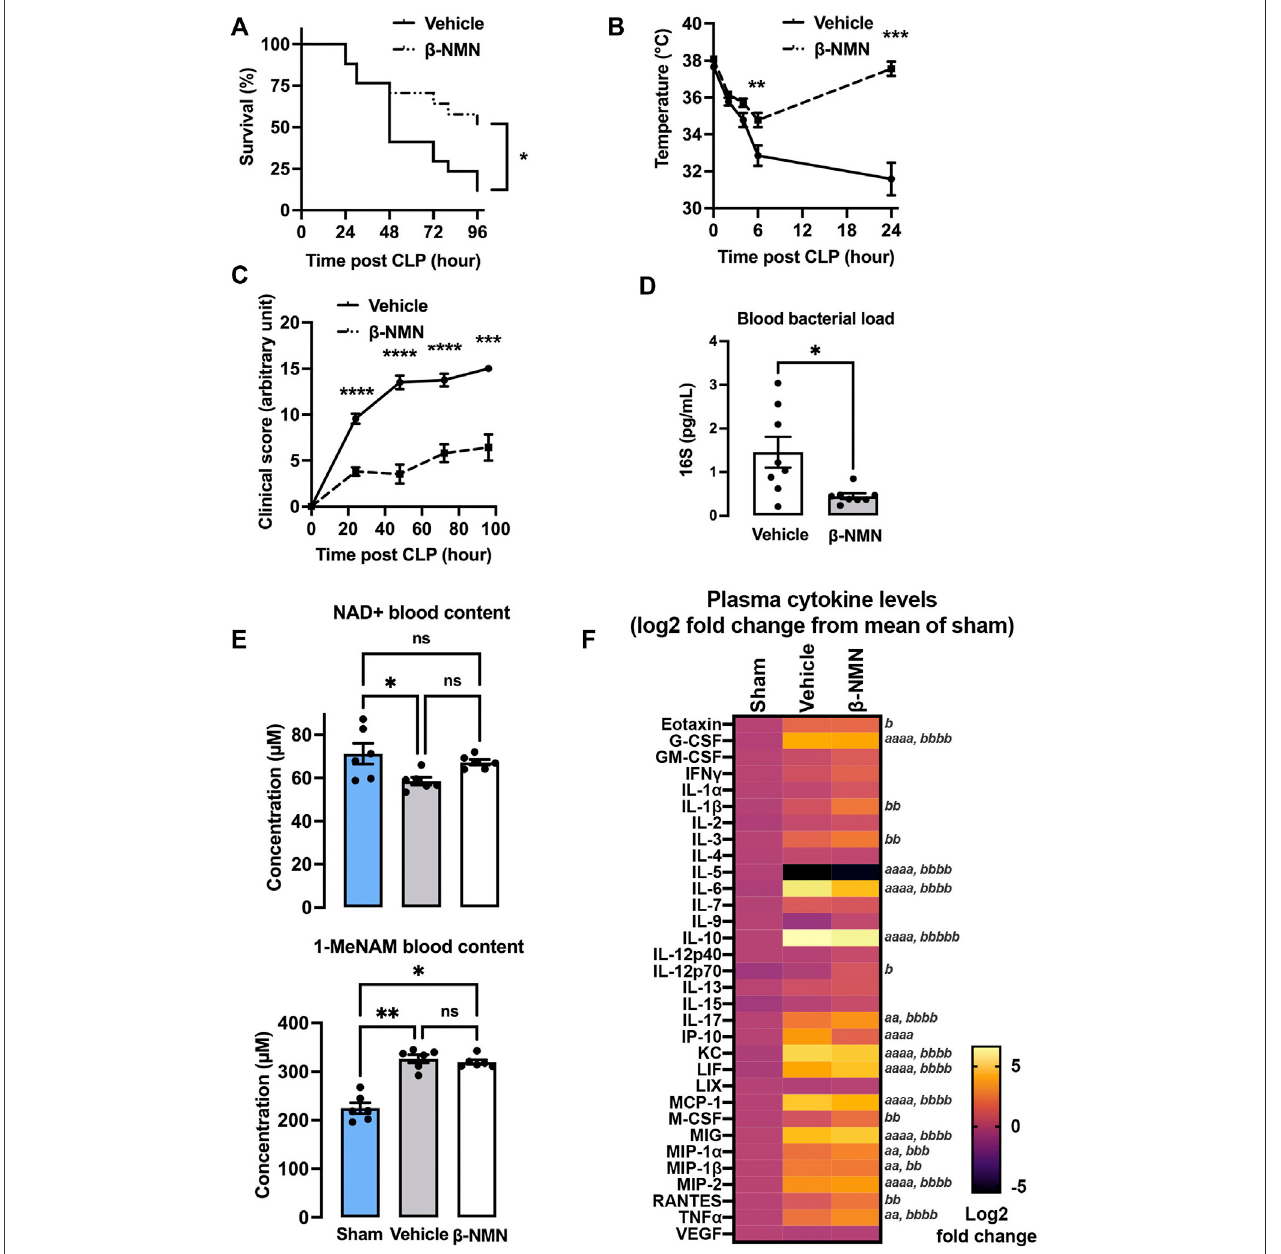
FIGURE 1 | Survival, clinical, and biological parameters in the CLP-induced septic mouse model. Saline (0.9% NaCl; vehicle) or β -NMN at 185 mg/kg was immediately administered after CLP and everyday for 4 days. (A) Survival wasrecorded every 12 h for the fi rst 2 days and then once per day. Data are representative of two independent experiments and are mean ± SEM; n = 17 for each group; * p < 0.05 vs. vehicle. (B) Rectal temperature was monitored every 2-4 h for 1 day. Data are representative of two independent experiments and are mean ± SEM; n = 16 for each group; ** p < 0.01; *** p < 0.001 vs. vehicle. (C) Clinical score was monitored once per day for 4 days and adapted according to the MSS score. Data are representative of two independent experiments and are mean ± SEM; n = 12 – 17 for each group; *** p < 0.001; **** p < 0.0001 vs. vehicle. (D) Blood of vehicle and β -NMN mice were collected 24 h post CLP, and bacterial DNA (16S) was extracted and quanti fi ed byqPCR. Dataare mean± SEM; n= 8foreach group; * p < 0.05 vs. vehicle. (E) Blood from sham, vehicle, and β -NMN mice were collected and acidi fi ed 24 h postCLPandNAD+,and1-MeNAMweredosed byUHPLC. Dataaremeans±SEM;n=6foreachgroup;ns=non-signi fi cant;* p < 0.05;** p < 0.001versusvehicle. (F) Heatmap of 32 in fl ammatory mediators. Plasma from the sham, vehicle, and β -NMN mice was collected 24 h post CLP, and 32 in fl ammatory mediators (cytokines, chemokines,andgrowthfactors)werequanti fi edusingaMouseCytokine/ChemokineArray32-plexassay.DataweretransformedonLog2-fold-changefromthemean relativetothesham group and were displayed asaheatmap. n =4-6for each group; ap < 0.05; aa p < 0.01; aaaa p < 0.0001vehicle vs. sham; bp < 0.05; bb p < 0.01; bbb p < 0.001; bbbbp < 0.0001 β -NMN vs. sham. Note: there isno signi fi cantdifference between vehicle and β -NMNgroups. G-CSF = granulocyte-colony stimulating factor; GM-CSF = granulocyte-macrophage colony-stimulating factor; IFN- γ = interferon gamma; IL = interleukin; IP-10 = interferon gamma-induced protein 10; KC =